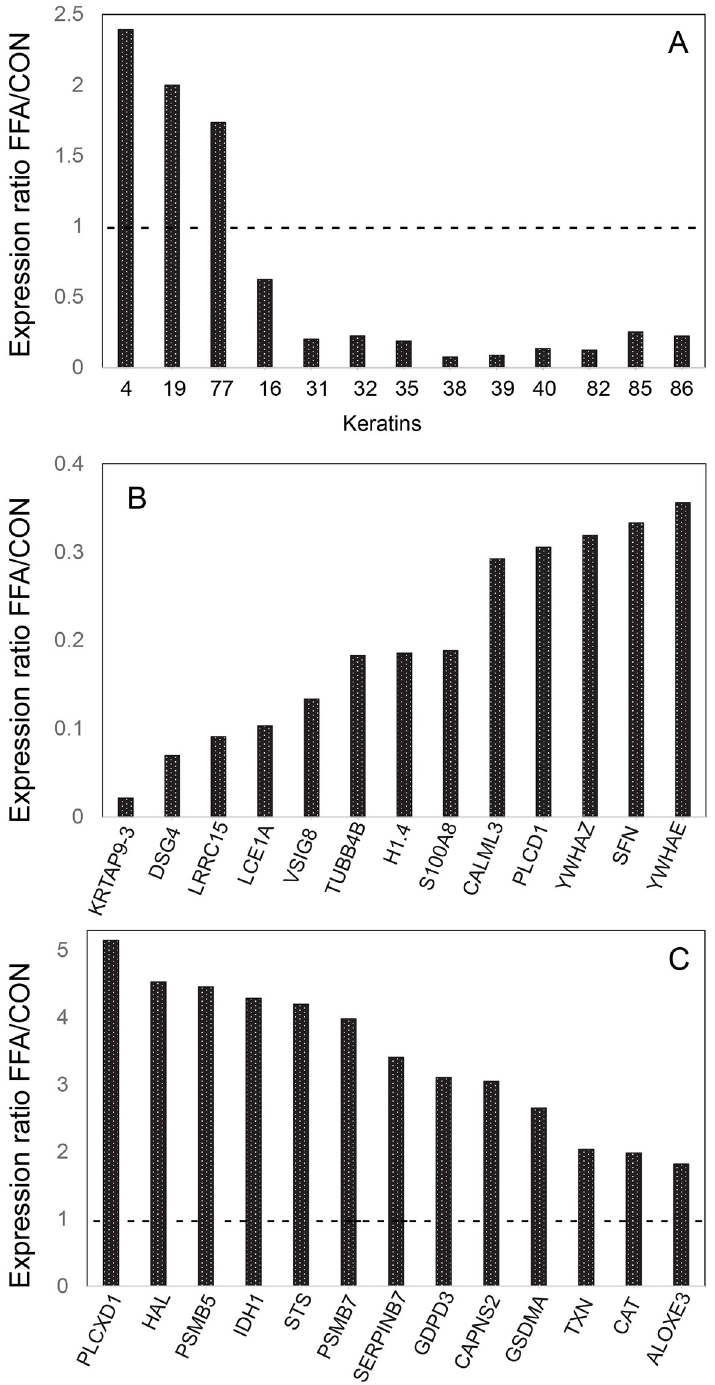
Fig 2. Ratios of expression levels of proteins found significantly different in FFA compared to asymptomatic control forehead samples. Illustrated are (A) 13 keratins that were expressed at significantly different levels in FFA samples, (B) 13 representative proteins found at lower levels in FFA samples, and (C) 13 representative proteins found at higher levels in FFA samples.